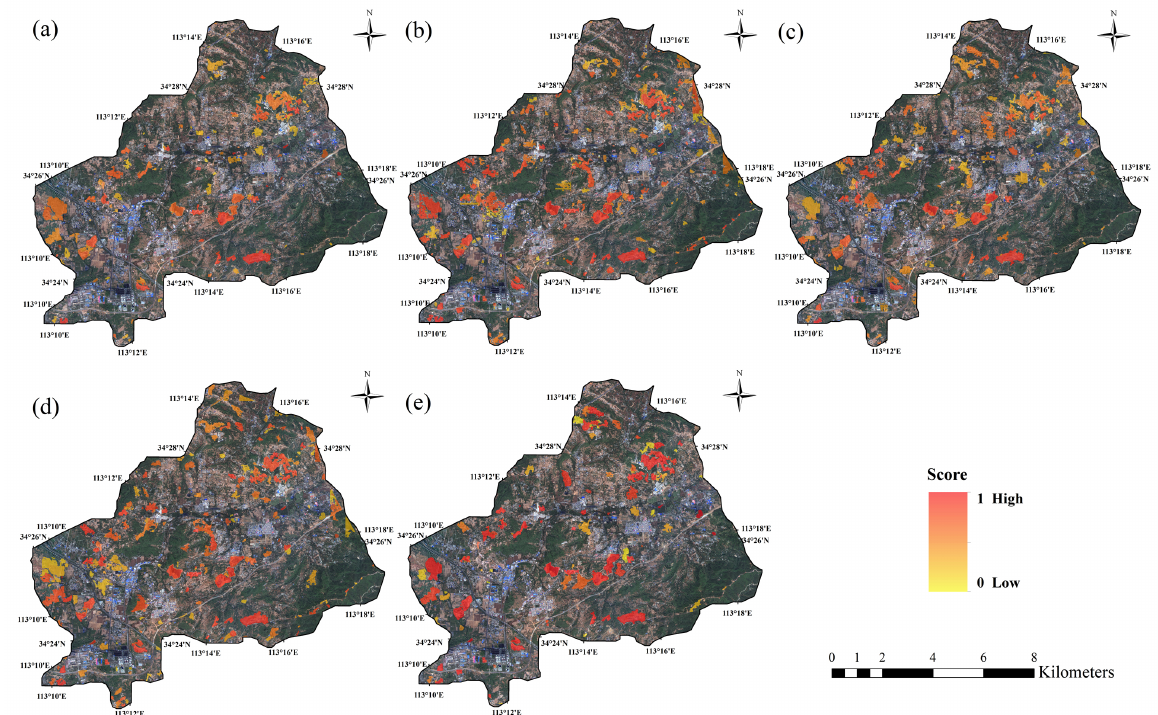
Figure 10. Detection results on Gaofen satellite true-color image in Daye Town. ( a ) Detection result by BlendMask model; ( b ) detection result by BlendMask-VoV model; ( c ) detection result by CondInst model; ( d ) detection result by CondInst-VoV model; ( e ) detection result by Mask R-CNN model.